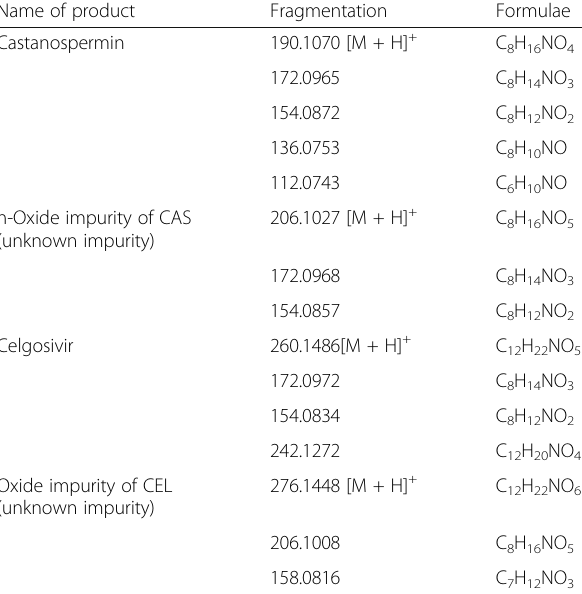
Table 2 HR-MS pseudo fragmentation profile for formulae confirm of the n-oxide impurity of castanospermin and celgosivir Name of product